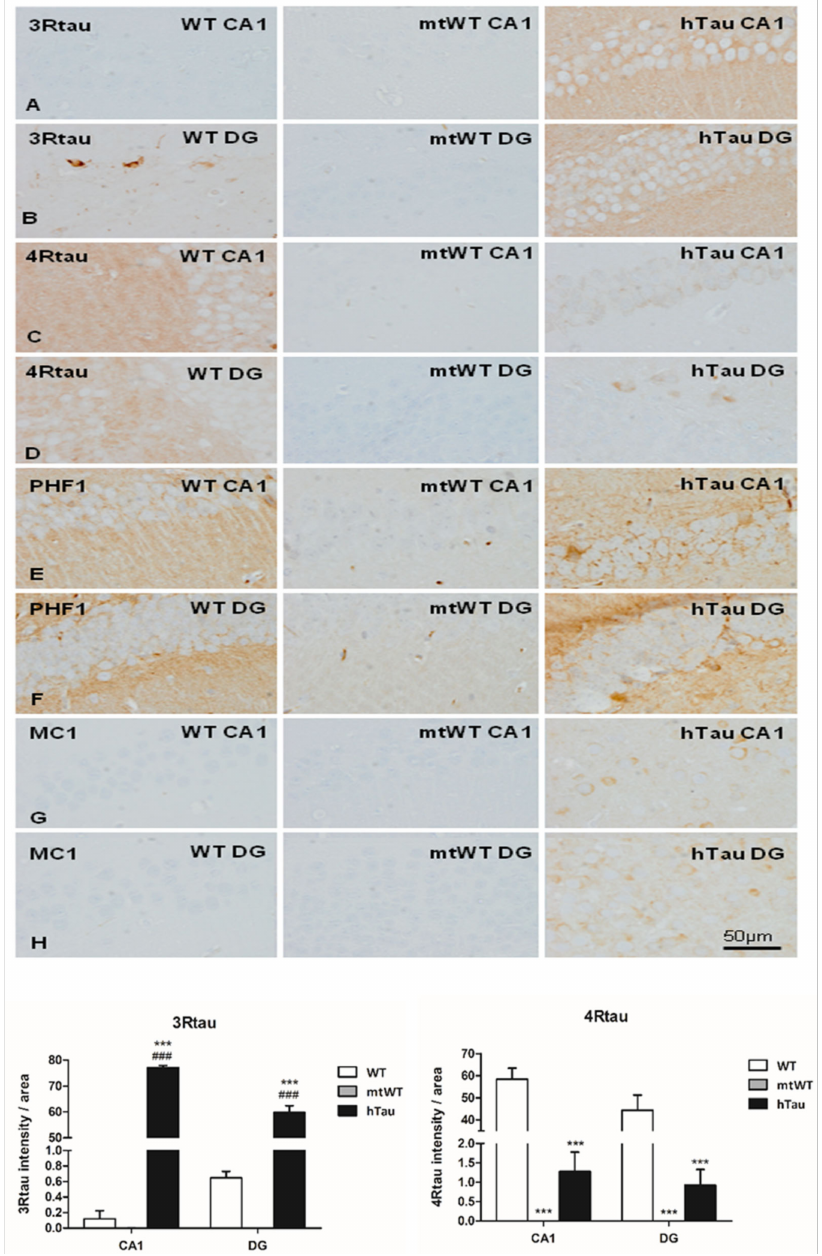
Figure 1. Representative images of 3Rtau ( A , B ), 4Rtau ( C , D ), PHF1 ( E , F ), and MC1 ( G , H ) expression in the CA1 region of the hippocampus and dentate gyrus ( GD ) in WT, mtWT, and hTau at the age of 9 months. In hTau mice, 3Rtau predominates, whereas only 4Rtau is expressed in WT mice. Weak PHF1 immunoreactivity occurs in the neuropil in WT, but PHF1-immunoreactive neurons are only seen in hTau mice. MC1 antibodies decorate weak globular cytoplasmic deposits in a subpopulation of neurons in hTau mice. MC1 is negative in WT. As expected, immunohistochemistry with antibodies against 3Rtau, 4Rtau, PHF1, and MC1 is negative in mtWT transgenic mice. Paraffin sections with slight haematoxylin counterstaining, bar = 50 µ m. Graphs show quantitative densitometry for anti-3Rtau and anti-4Rtau immunostaining expressed as a percentage of arbitrary units per area in CA1 and dentate gyrus ( DG ) regions in WT, mtWT, and hTau mice. Results were analyzed with one-way ANOVA and post hoc Tukey. Differences between groups were considered statistically significant at *** p < 0.001 when comparing hTau with WT, and ### p < 0.001 when comparing htau with mtWT. Note that 4Rtau is predominant in WT mice, excepting the DG in which 3Rtau positive neurons are also localized in the inner layer. In contrast 3Rtau predominates in CA1 and DG in hTau transgenic